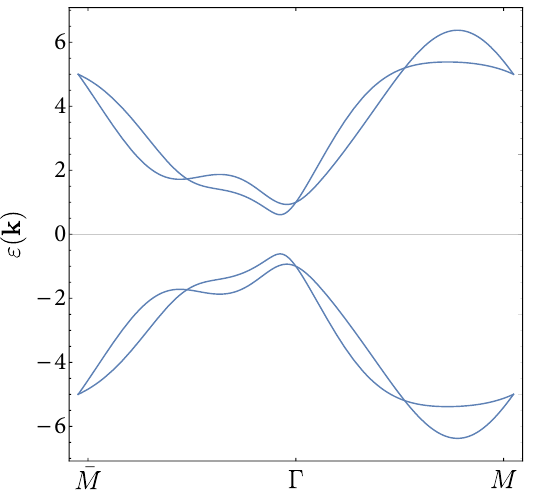
Figure 6: Band structure of the model used in this work, with A = 1, B = 1, C = 1. M = 3.5. The chemical potential is fixed at µ = 0. For these parameters, the gap ≈ 0.5, with direct transitions occurring along the ¯ M − Γ E g